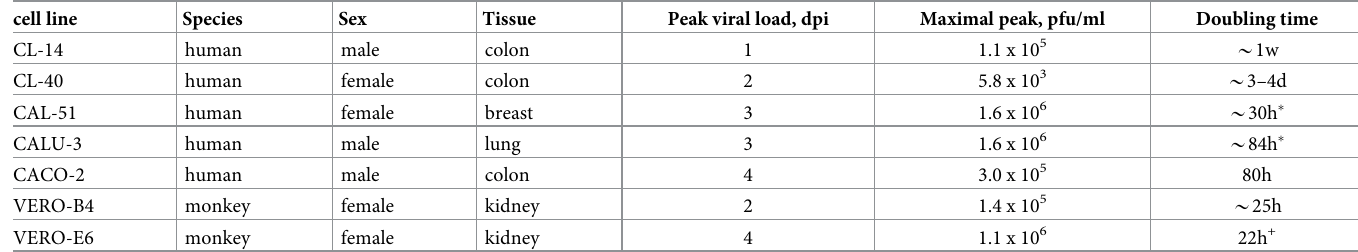
Table 1. Permissive cell line